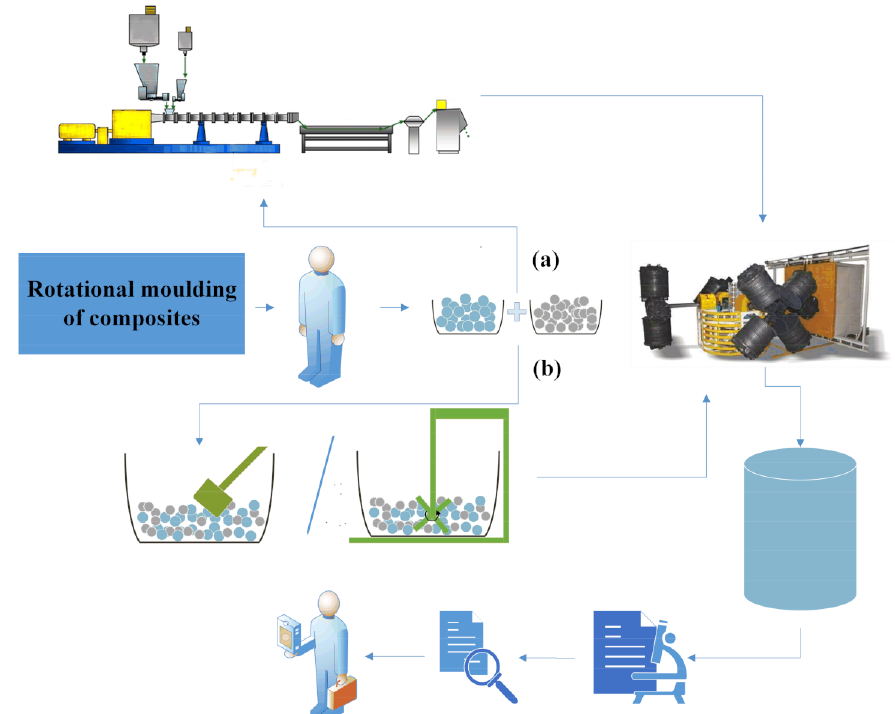
Figure 3. Scheme illustrating the fabrication of composites by rotational moulding: ( a ) mixing filler with polymer matrix by extrusion (materials—extrusion—granulation—rotational moulding— product—research–sales), ( b ) without extrusion (materials—manual or mechanical mixing— rotational